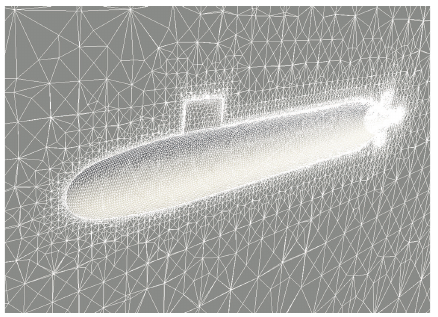
Figure 2: Tetrahedral mesh around the DARPA submarine.